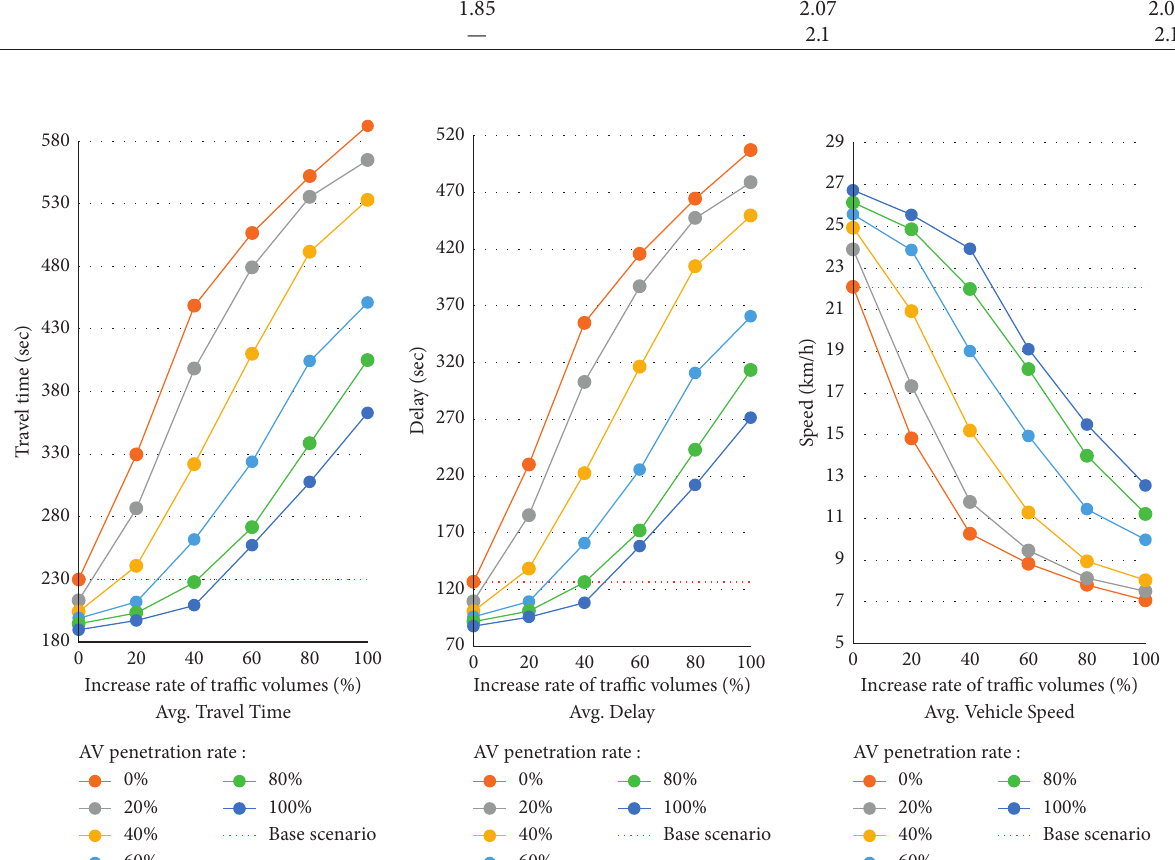
Figure 5: Traffic flow by AV penetration rate and traffic volume increment.